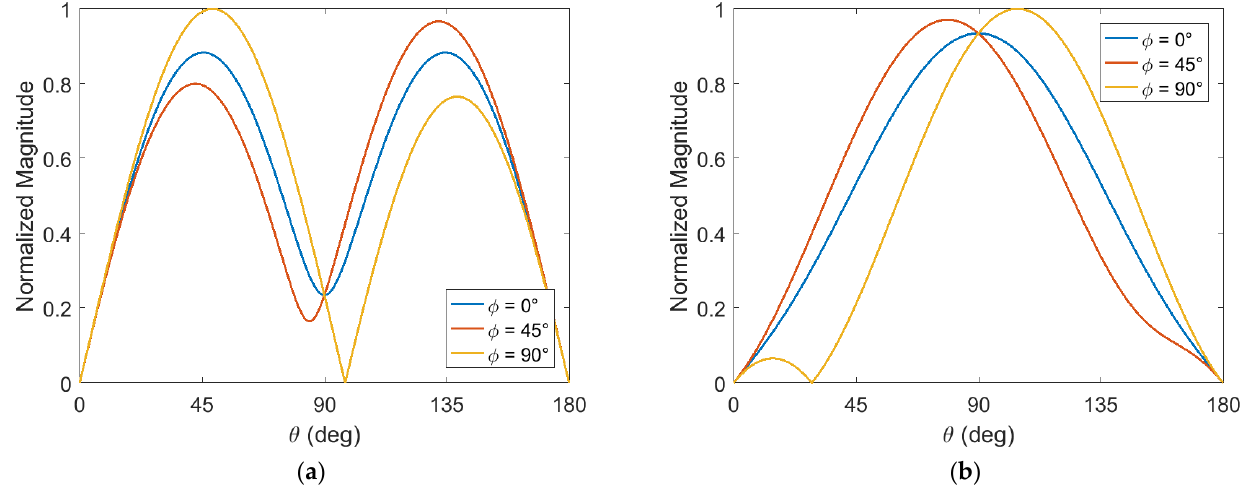
Figure 4. Normalized magnitude of the transverse effective magnetic field contribution from ap- plied stress: ( a ) for nickel; ( b ) for magnetite. stress: ( a ) for nickel; ( b ) for